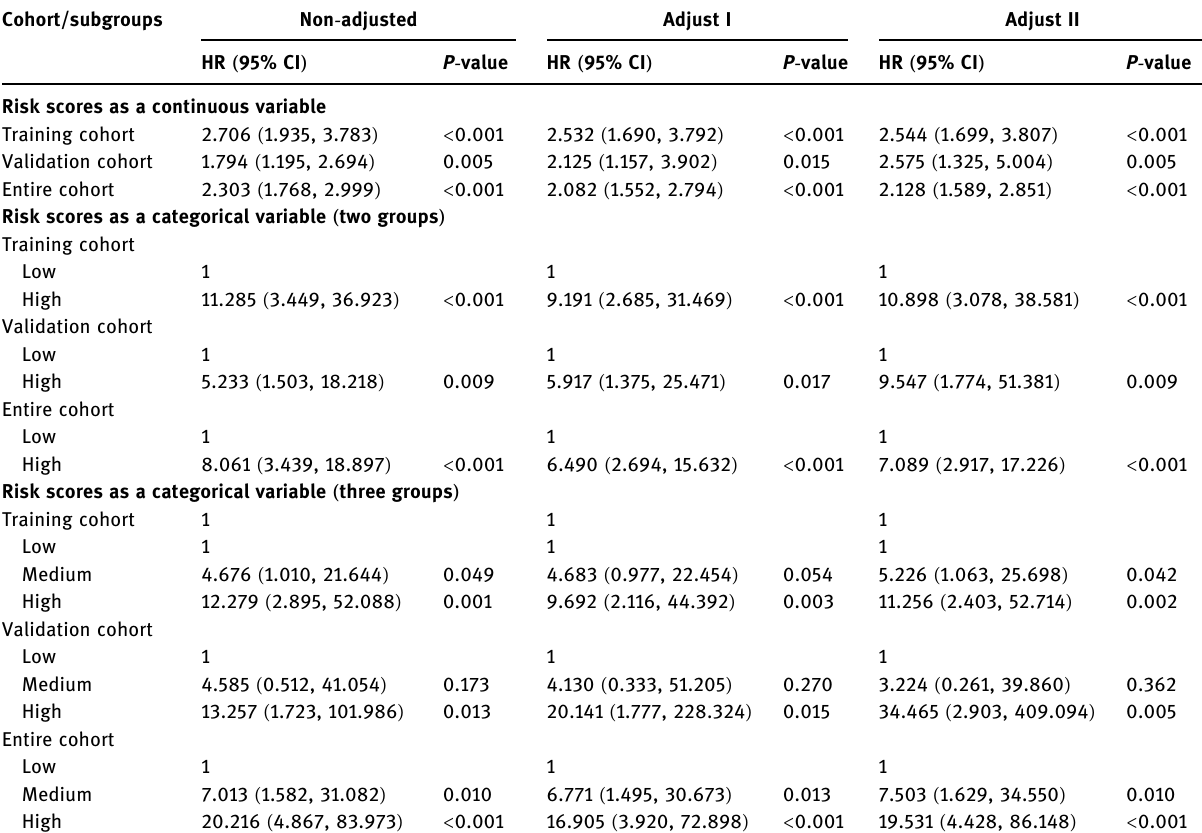
Table 3: Univariate/multivariate COX regression analyses of the associations of autophagy - related lncRNAs risk scores with the PFI of patients with papillary thyroid carcinoma